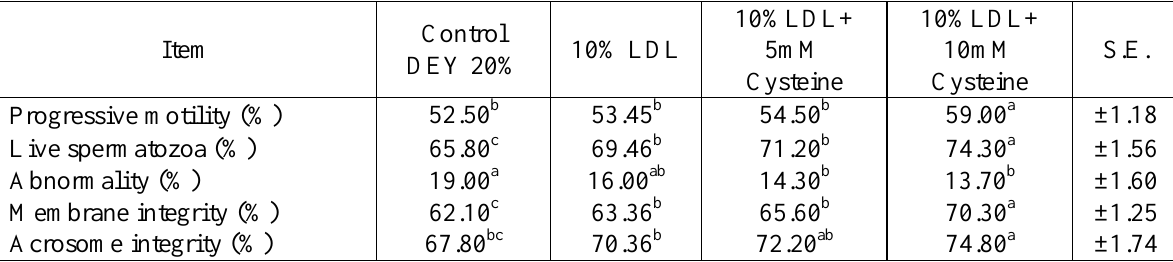
Table 5: Effects of LDL and Cysteine based extender on Post-equilibration at 5 o C parameters of Holstein bull spermatozoa (Mean ± S.E):